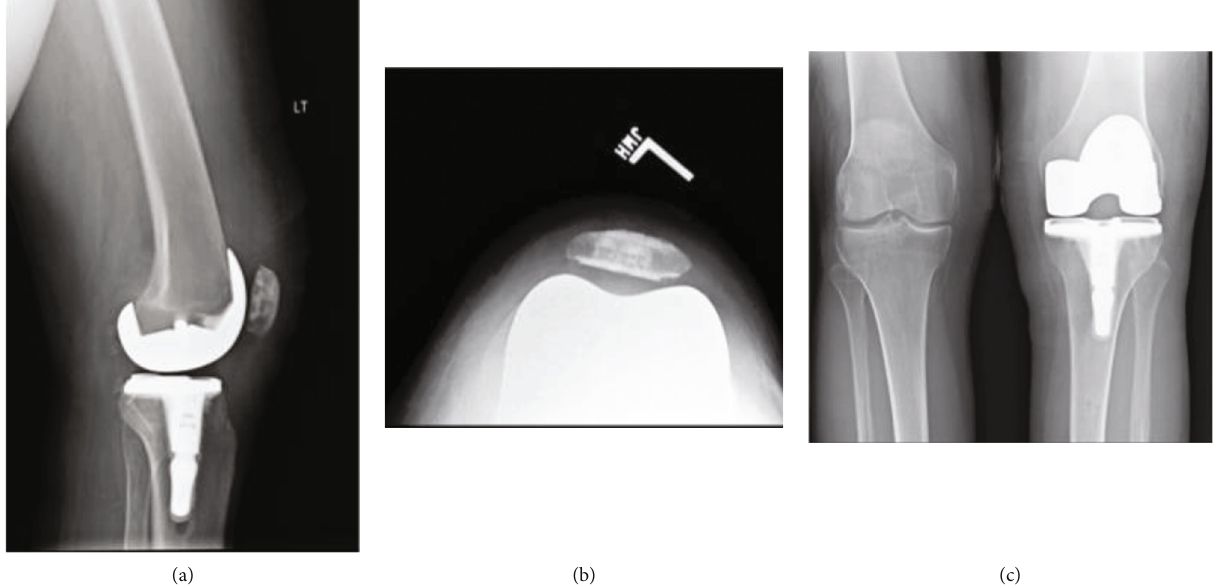
Figure 22: Postoperative X-rays showing balanced gap spacing following TKA (a, c), as well as appropriate patellar tracking (b) for Case